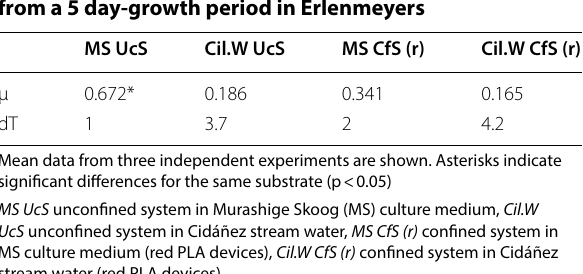
Table 1 Growth kinetic parameters of C. vulgaris